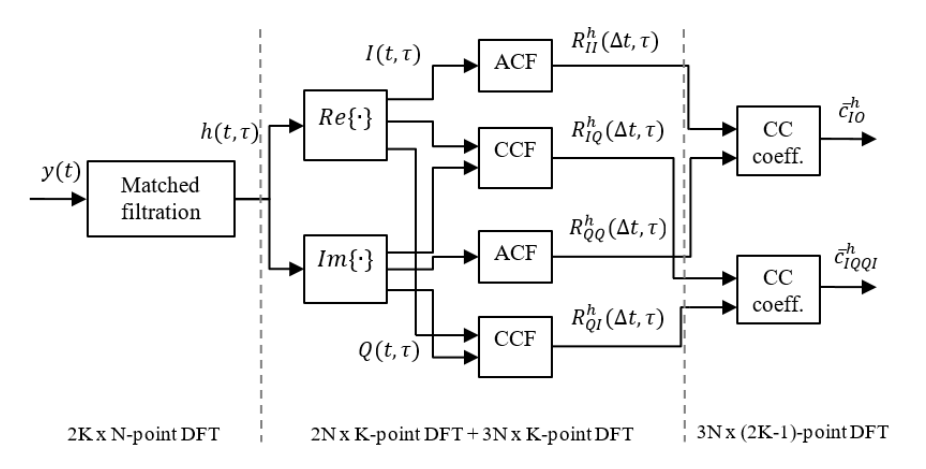
Figure 1. Process of calculating cross-correlation coefficients based on the impulse response h ( t , τ ) of K realisations in t domain and N samples in τ